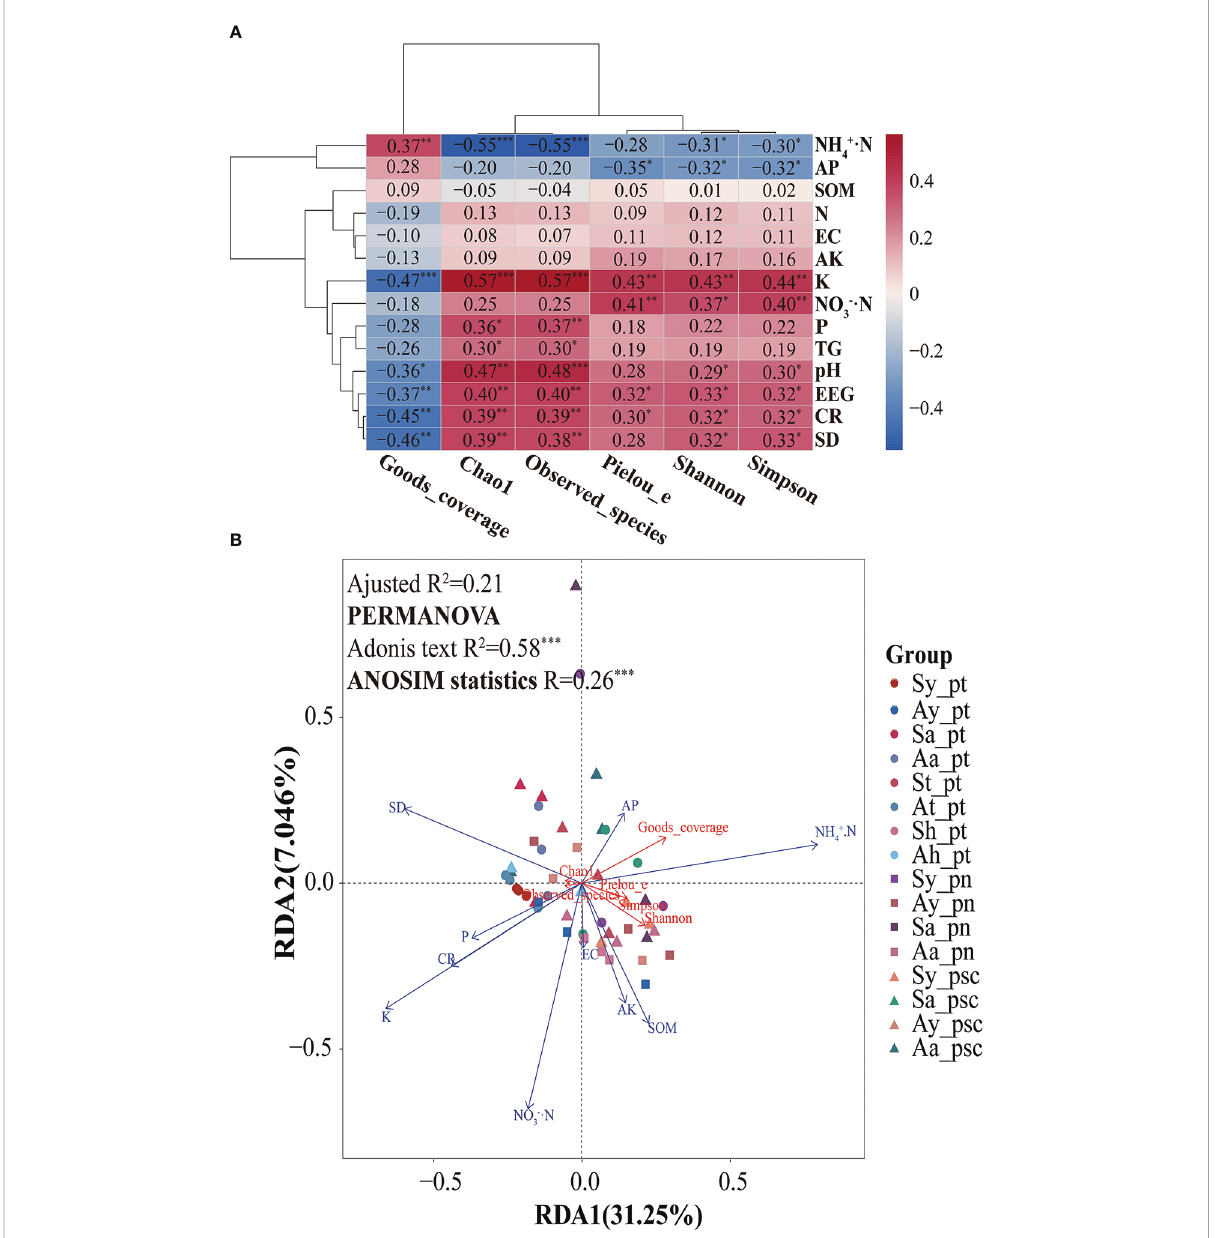
FIGURE 5 AMF community response and potential drivers. (A) Heatmap of the correlation analysis between the alpha diversity of poplar root AMF communities and environmental factors. (B) Constrained ordination analysis (db-RDA) of the alpha diversity and environmental factors of the AMF community in poplar roots. *0.01 < p < 0.05; **0.001 < p < 0.01; *** p <